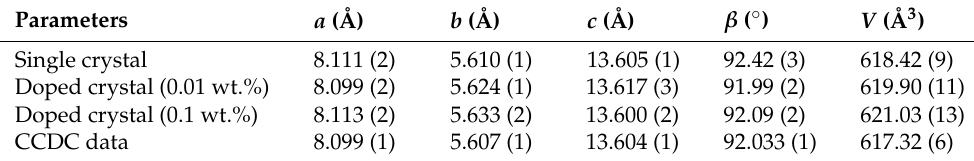
Table 2. Change in crystallite size corresponding to different planes of pentacene-doped p-ter- phenyl crystals.